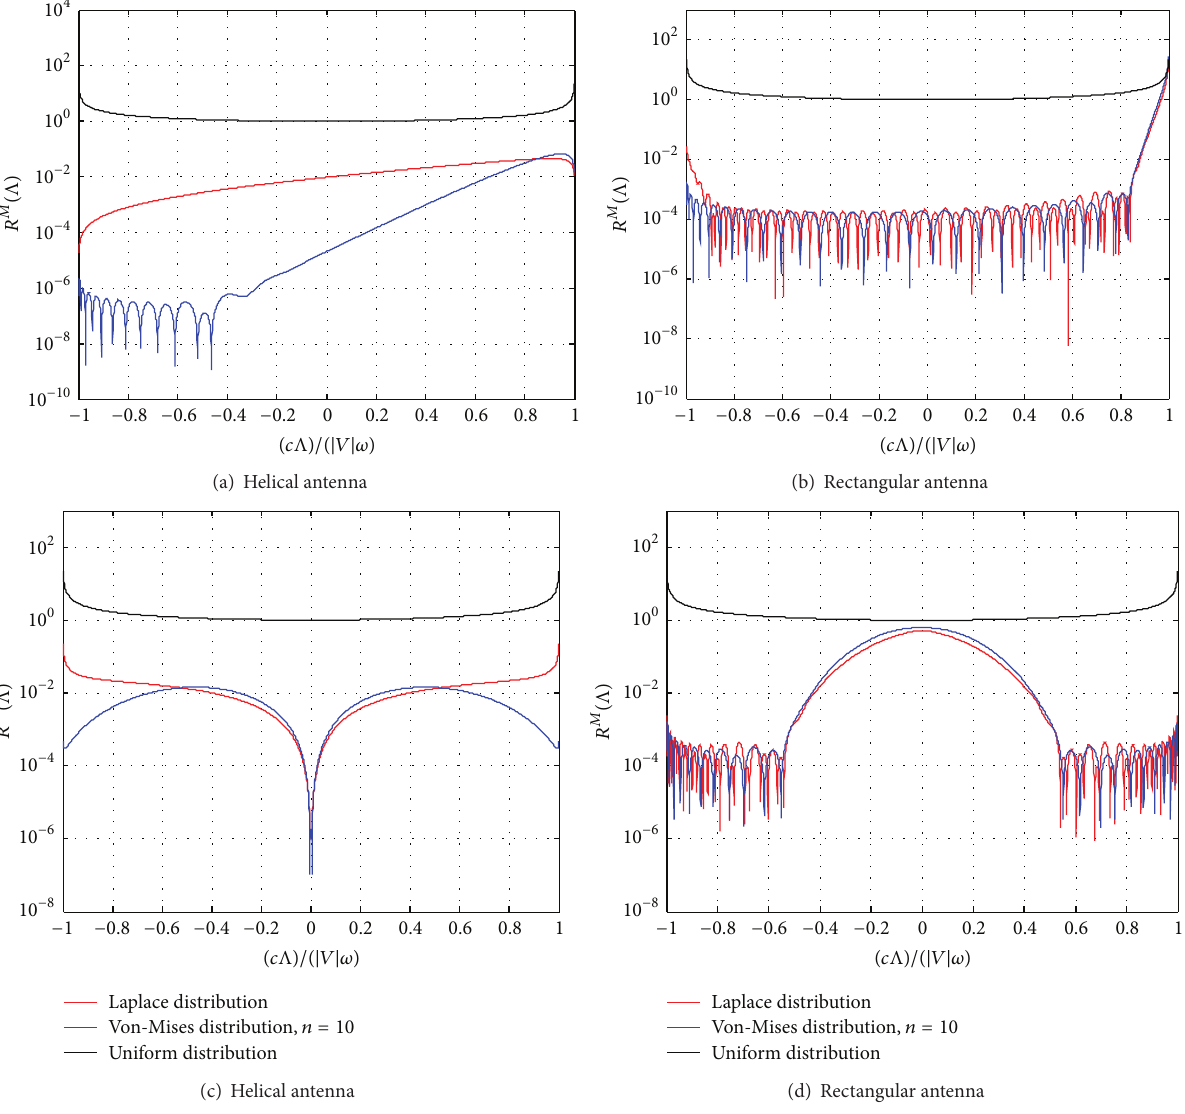
Figure 5: PSD of UWB channels, MS moves in the positive direction of the 𝑥 -axis ((a), (b)) and 𝑦 -axis ((c), (d)), two antenna types employed at the MS, nonisotropic propagation (Laplacian or von-Mises distributed), and isotropic environment (uniformly distributed).